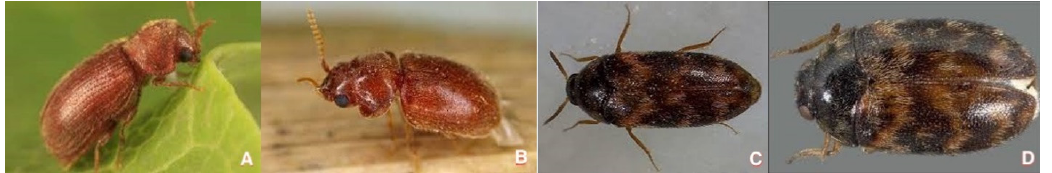
Figure 3. Downloaded sample images of insects used in the study. Cigarette beetle ( A , B ) and warehouse beetle ( C , D ).